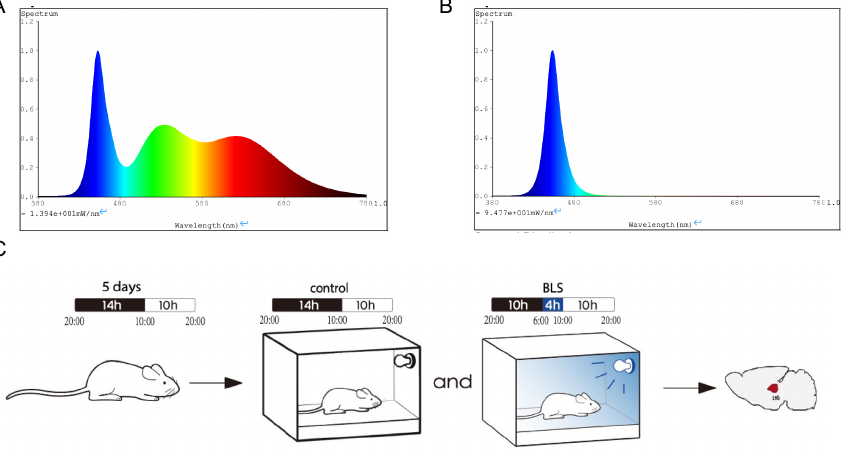
Figure 1. ( A ) White light spectrum. ( B ) Blue light spectrum. ( C ) Experimental design for control or BLS paradigms. BLS